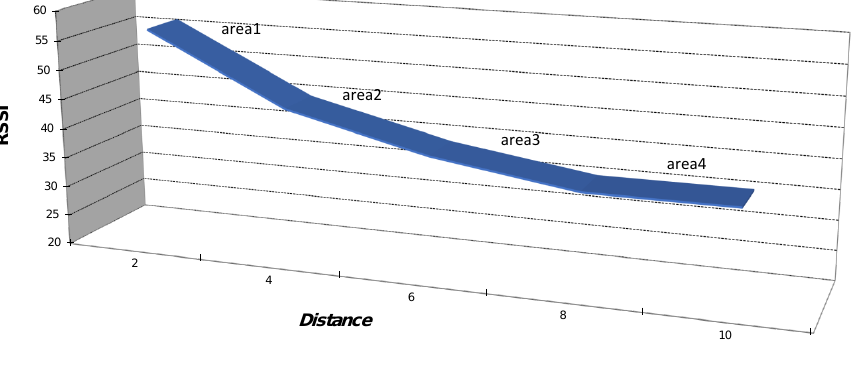
Figure 2. RSSI vs. distance